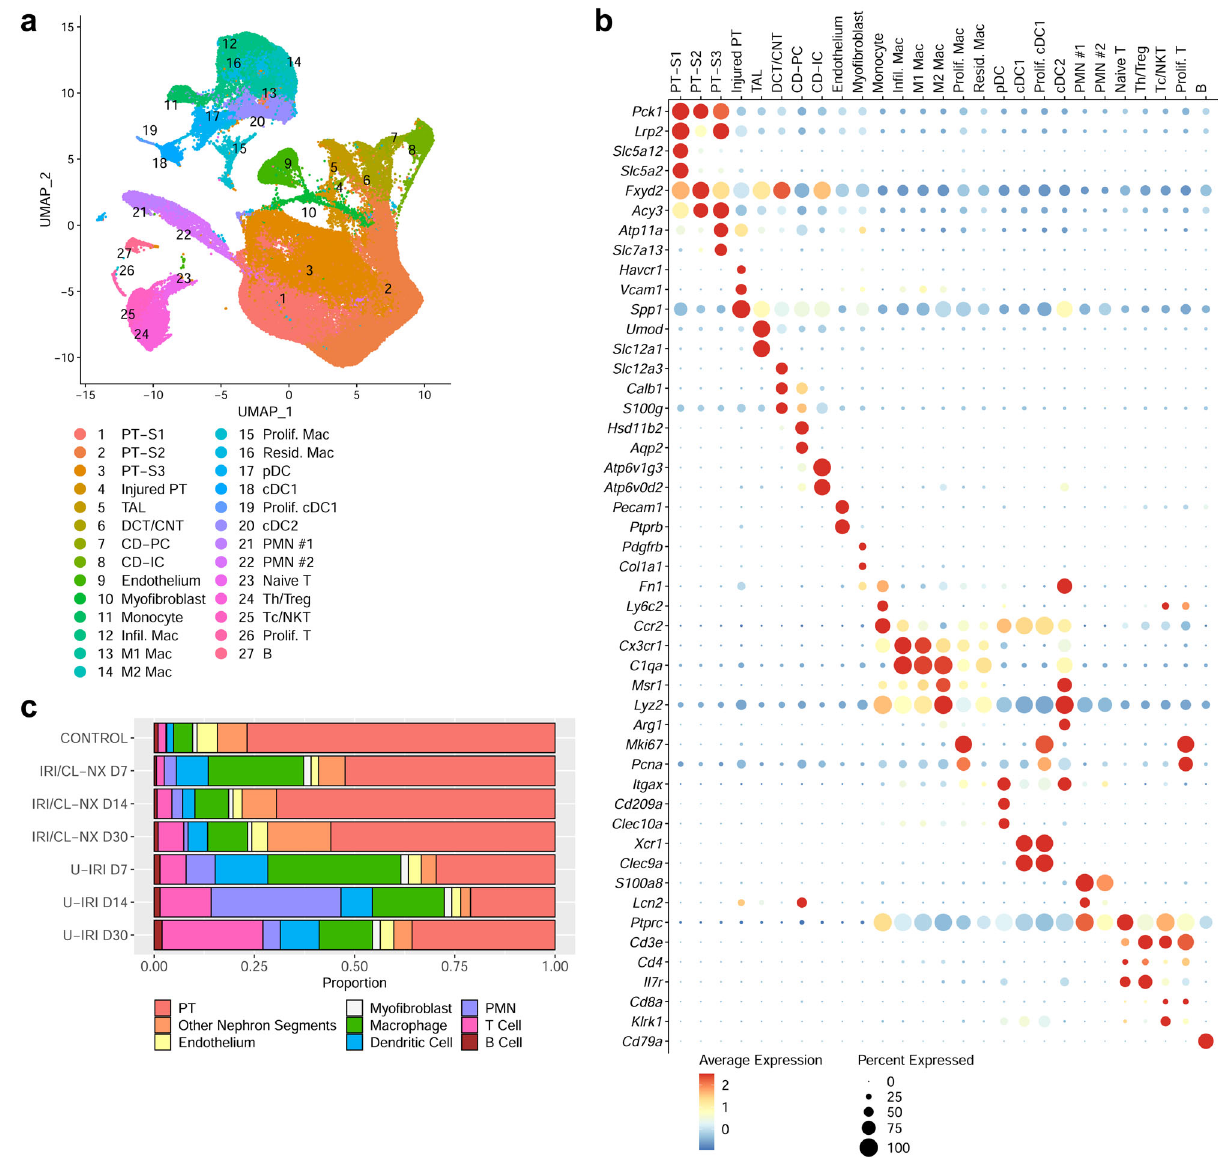
Fig. 3 | Integrated scRNA-seq analysis of differential cell type populations betweenIRI/CL-NX and U-IRI kidneysand controlkidneys. Wild-typemice were subjected to 27min of ischemia/reperfusion injury (IRI) with contralateral nephrectomy(IRI/CL-NX)orunilateralIRI(U-IRI)andsacri fi cedonday7,14,and30 after injury. Injured kidneys ( n =2 kidneys/model/time point) and normal control kidneys ( n =2 kidneys) were harvested for single-cell-RNA-sequencing analysis. a UMAP projection of 95,343 cells from integrated kidneys. Cell clusters were identi fi ed using the composite data from all cells by kidney cell and immune cell lineage-speci fi c marker expression as shown in b . PT, proximal tubule; TAL,